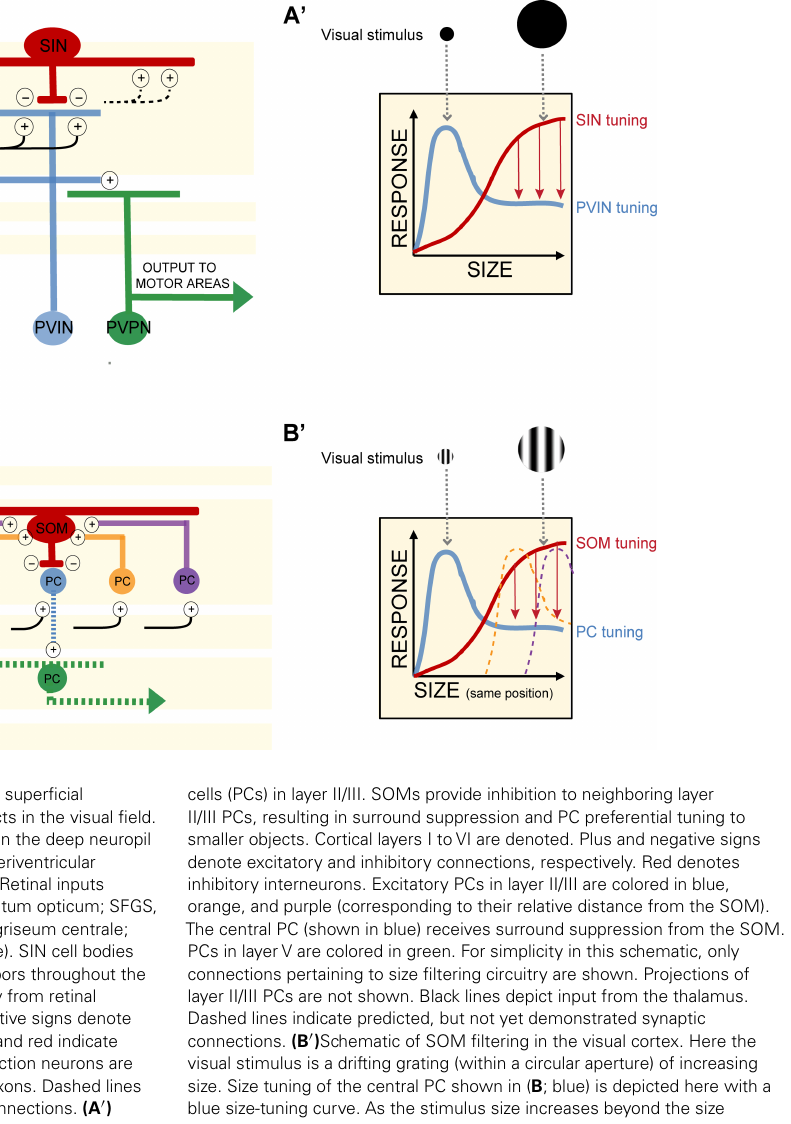
FIGURE 1 | (A) In the optic tectum of the zebrafish larva, superficial interneurons (SINs) are preferentially tuned to large objects in the visual field. Periventricular neurons (PVNs) with dendrites stratifying in the deep neuropil are preferentially tuned to small objects. PVINs denote periventricular interneurons, PVPNs, periventricular projection neurons. Retinal inputs distribute among four main layers of the tectum (SO, stratum opticum; SFGS, stratum fibrosum et griseum superficiale; SGC, stratum griseum centrale; SAC/SPV, stratum album centrale/stratum periventriculare). SIN cell bodies are located in the SO and extend dendritic and axonal arbors throughout the SFGS. SINs may receive excitatory synaptic input directly from retinal ganglion cell axons or from PVINs or both. Plus and negative signs denote excitatory and inhibitory connections, respectively. Blue and red indicate excitatory and inhibitory interneurons, respectively. Projection neurons are colored in green. Black lines depict retinal ganglion cell axons. Dashed lines indicate predicted, but not yet demonstrated synaptic connections. (A (cid:3) ) Schematic of SIN filtering in the optic tectum. As the size of the visual stimulus increases, SINs become activated and provide inhibitory input to sharpen the tuning of PVIN receptive fields. Size-tuning curves for SINs and PVINs are depicted by red and blue curves, respectively. Red arrows denote inhibition acting to sharpen tuning. (B) In the mouse visual cortex, somatostatin-expressing interneurons (SOMs) are preferentially tuned to large objects in the visual field and display no surround suppression. SOMs are positioned in layer II/III and receive lateral excitatory inputs from pyramidal